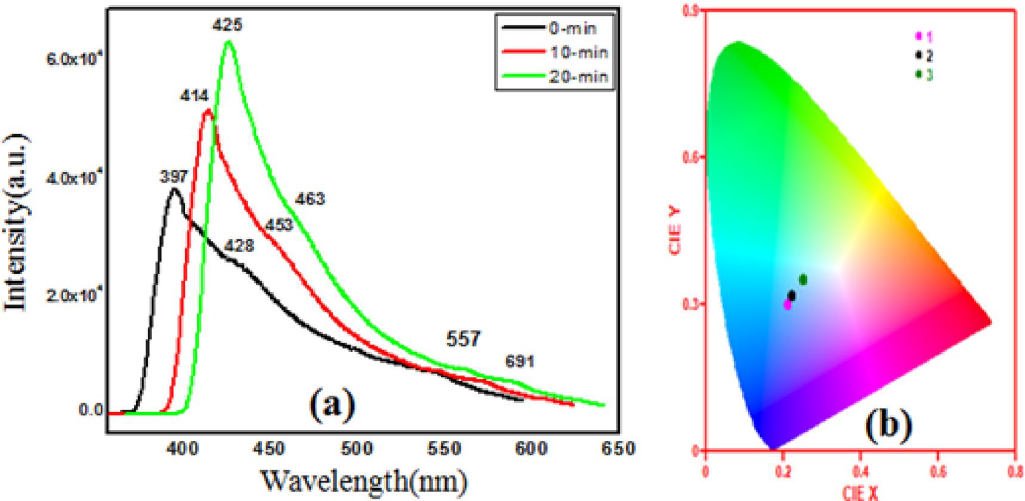
Figure 6. ( a ) PL spectra of of as-grown and irradiated ZnO-CdO coated films. ( b ) CIE diagram for colour identification of ZnO-CdO coated films at (0-min, 10-min and 20-min)